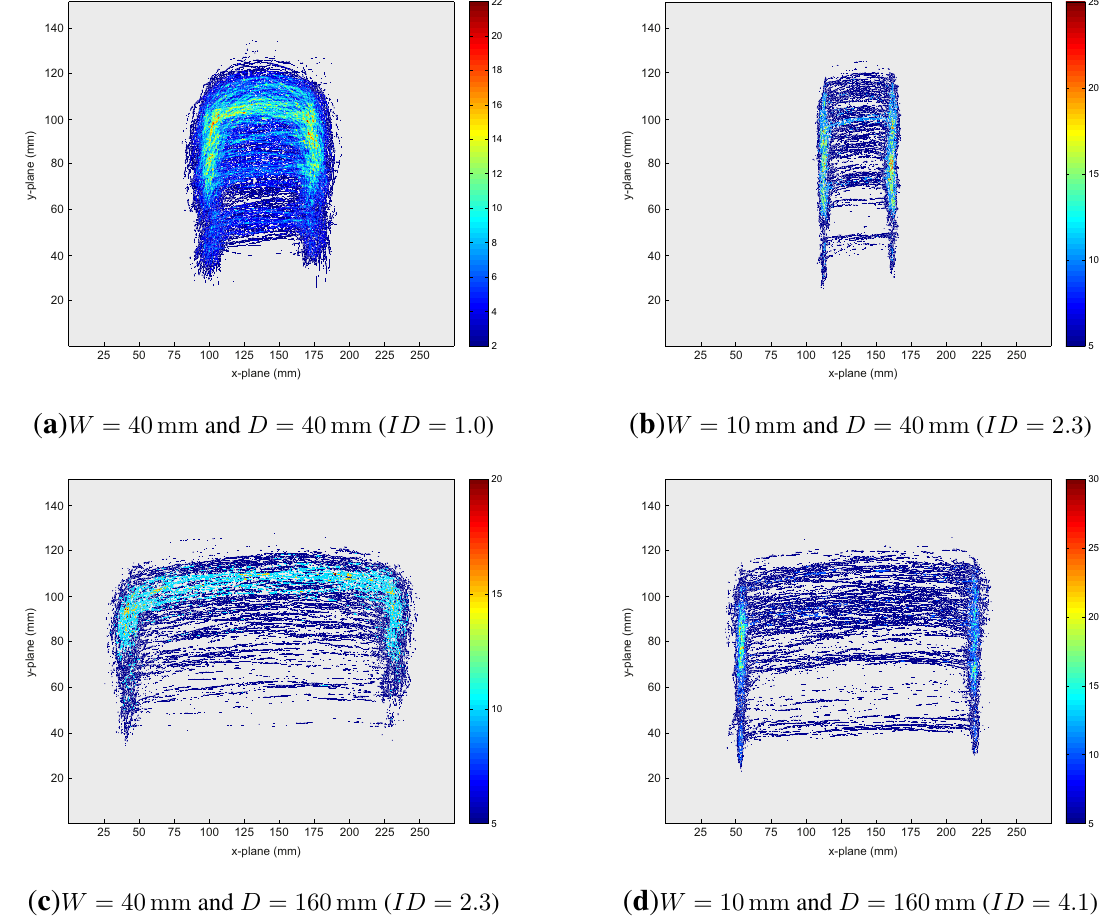
Figure 6. Aggregate accumulator plots for different indices of difficulty: ( a ) ID = 1 . 0 , ( b , c ) ID = 2 . 3 and ( d ) ID = 4 . 1